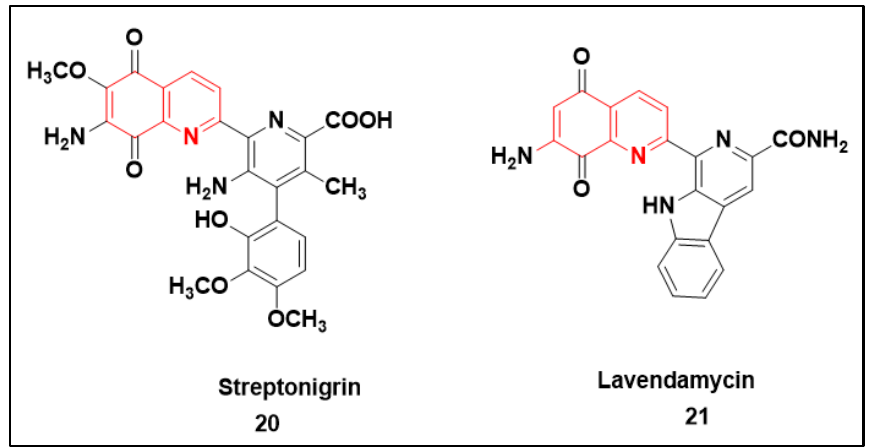
Scheme 9. Chemical structures of quinolones-based HSP90 inhibitors: Streptonigrin and Laven-